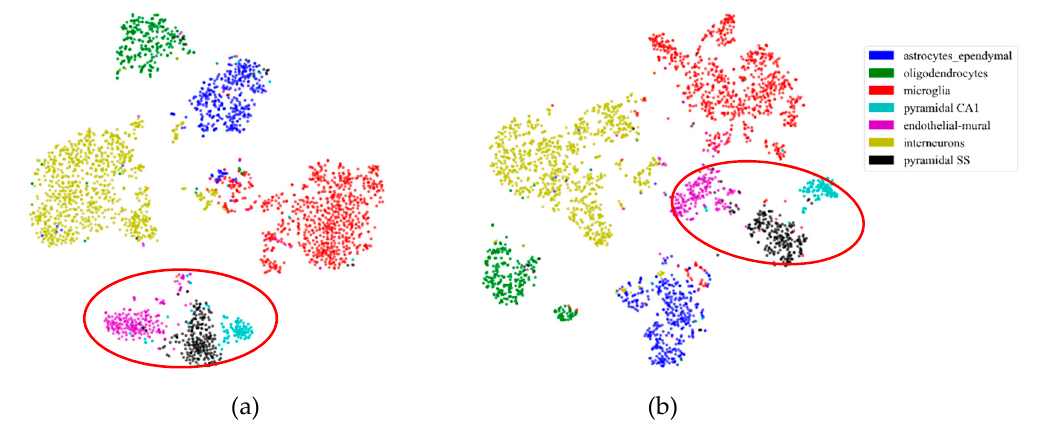
Figure 2. Comparison of no feature extraction (NFE) and non-negative matrix factorization (NMF) feature extraction. ( a ) The t -distributed stochastic neighbor embedding ( t -SNE) graph of mouse cortex data of 500 genes with NFE. ( b ) The t -SNE graph of mouse cortex data of 500 genes with NMF. The red oval circled clustering results of the astrocyte ependymal cells, endothelial mural cells, and microglia cells.